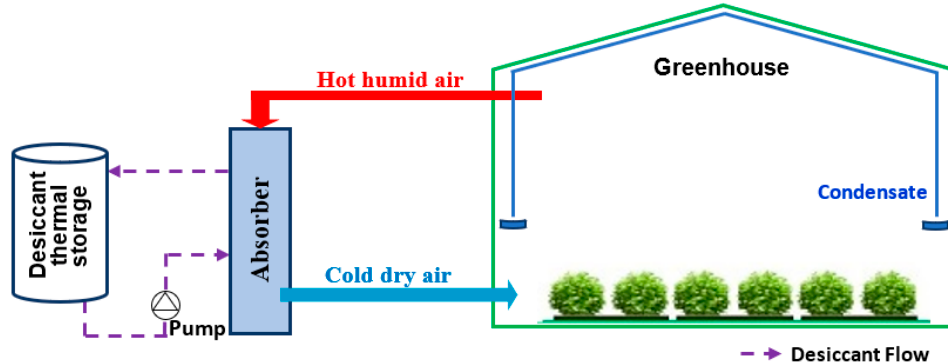
Figure 13. Closed desiccant greenhouse (daytime operation).